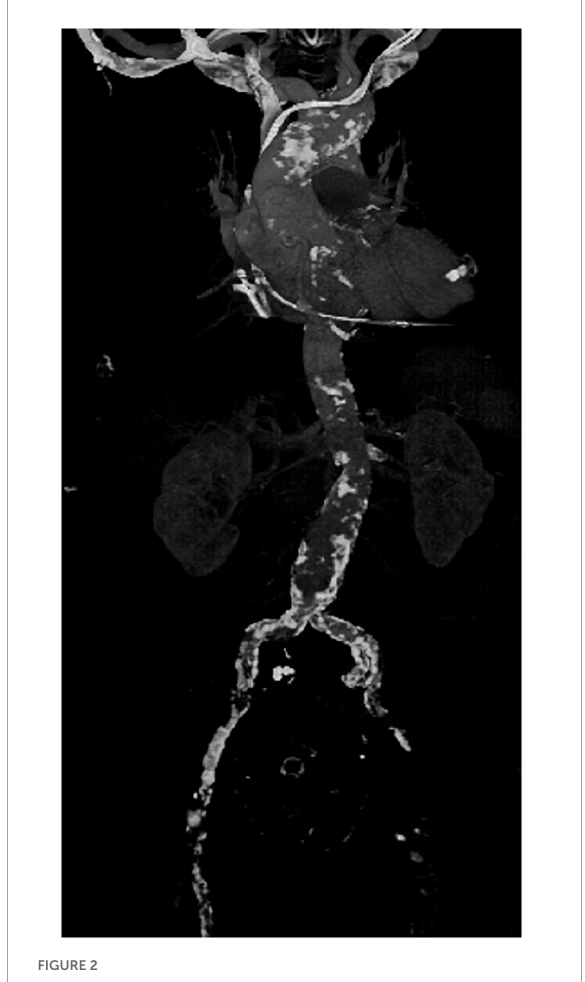
FIGURE2 Example of a computed tomography (CT) scan of the aorta of a patient with severe arteriosclerosis in the axillary artery, aortic arch abdominal aorta and especially the femoral vessels in which minimally-invasive surgery was performed by using an antegrade arterial perfusion via arteria axillaris.